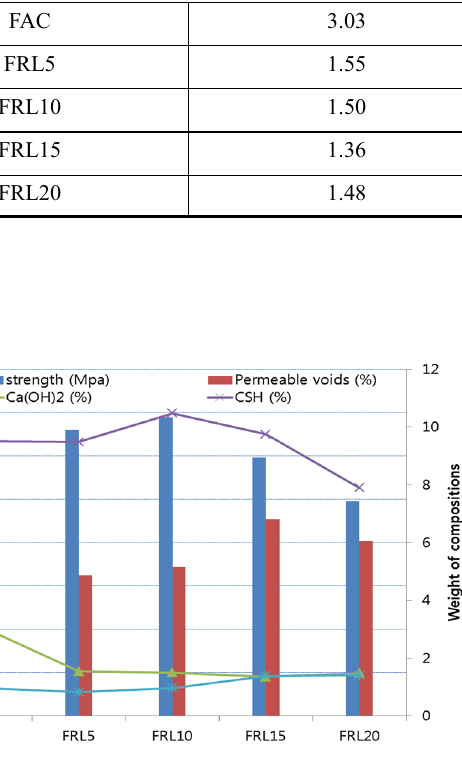
Table 6 TG/DTA Results for various FAC with increasing RHA and LP. Results